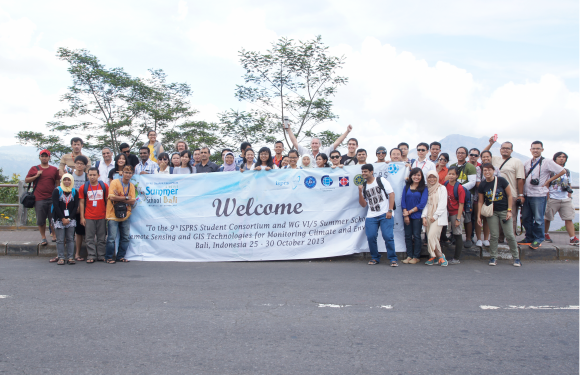
Figure 3. Participants during the field trip in the summer school held in Bali,